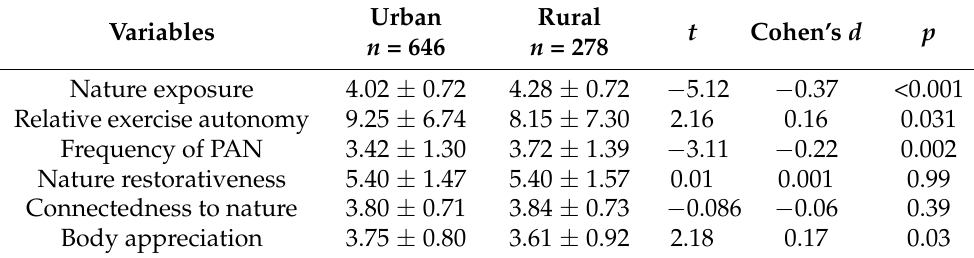
Table 2. Comparison of the study variables (m ± SD) across urban vs. rural place of residence groups ( n = 924).